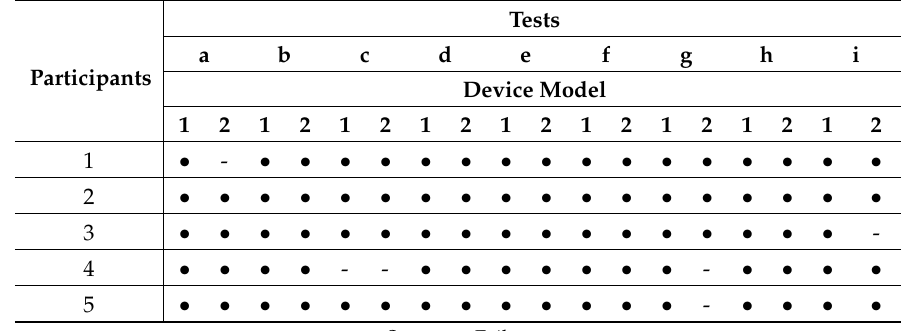
Figure 6. Testing procedure. (a) Walk along the corridor with an unknown obstacle; (b) Bypass several corners indoors; (c) Walk through the staircase; (d) Wall fallowing; (e) Detect the open door; (f) Detect an obstacle on the street; (g) Bypass an obstacle on the street; (h) Avoid collisions with pedestrians; (i) Interact with known objects. Table 2. Results of the